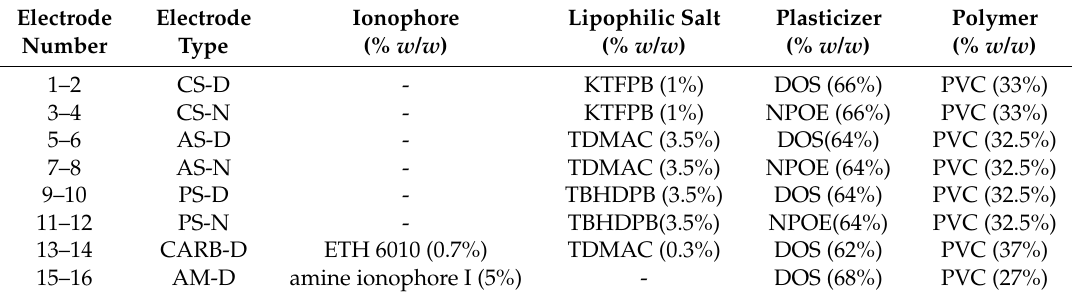
Table 3. Components used for sensor membranes